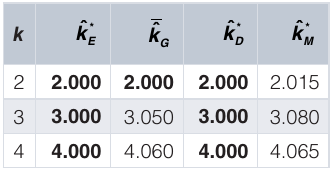
Table 7. Average cluster numbers over n = 200 runs.